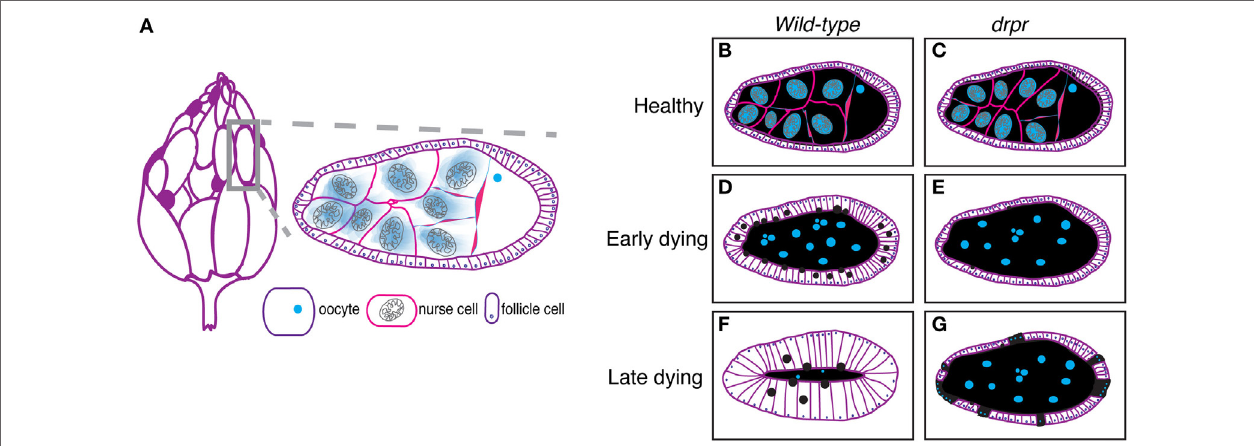
FiGURe 1 | The Drosophila ovary as a model for engulfment. (A) Each ovary (left) comprises strands of developing eggs called egg chambers. Stage 8 egg chamber (gray box) zoom (right) has three main cell types: germline-derived nurse cells and oocyte and somatically derived follicle cells. Dark purple egg chambers (left) correspond to the egg chambers that spontaneously die in the ovary. Ovary drawing adapted from Ref. (52). (b–G) Schematics of healthy and degenerating egg chambers in wild-type and draper Δ 5 mutant flies. Cell membranes are shown in purple, nuclei in blue, nurse cell cytoplasm in black, and follicular epithelium in white. Wild-type starvation-induced apoptotic nurse cells are cleared by enlarged follicle cells (D) until there is little to no germline material left (F) . draper mutant follicle cells do not enlarge and fail to clear germline material (e) . Follicle cells prematurely die (cyan dots) (G)